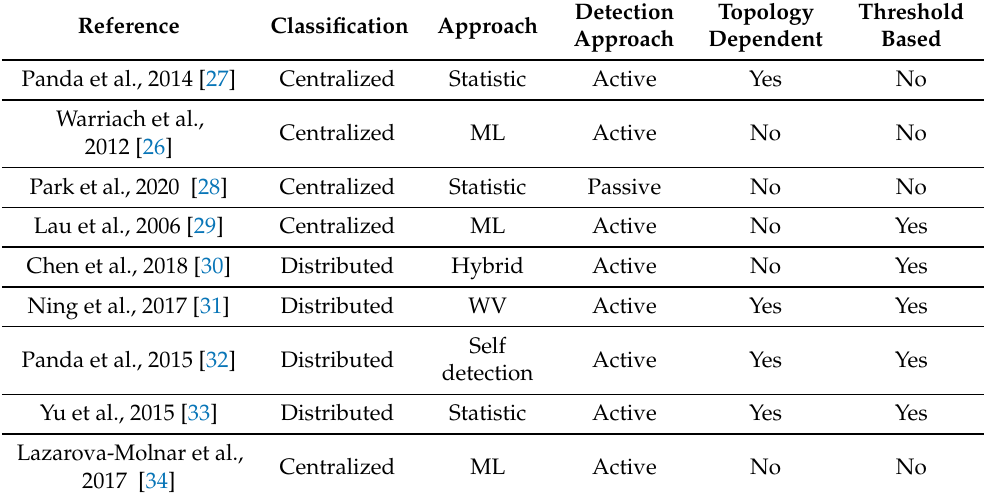
Table 2. Comparison of fault detection methods in microclimate control